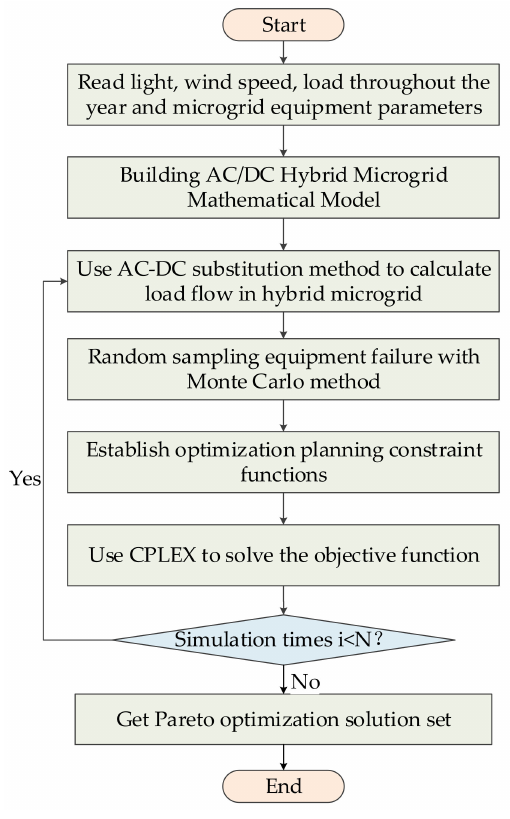
Figure 3. Optimization solution flow